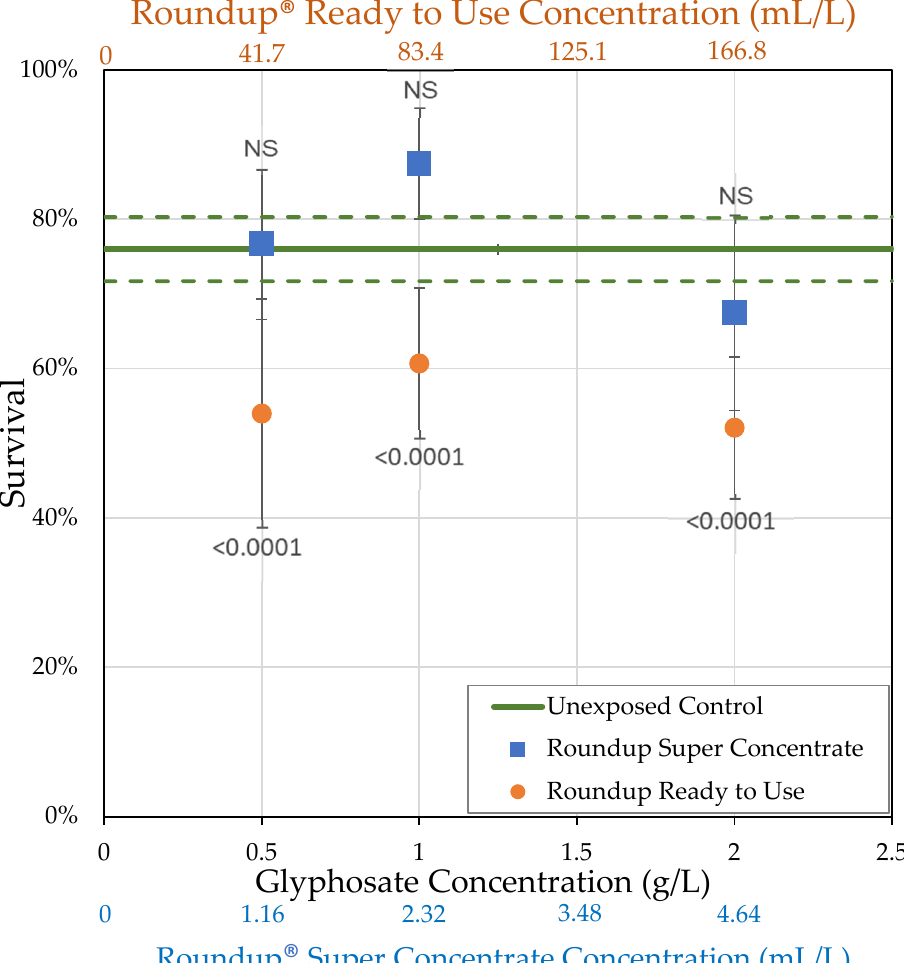
Figure 1. Average percent survival of D. melanogaster females unexposed (control) or exposed to Roundup ® in their food medium within 2 h of eclosion for 7 days ( ± std. error). The p -values shown are based on the t -tests in Table 2.